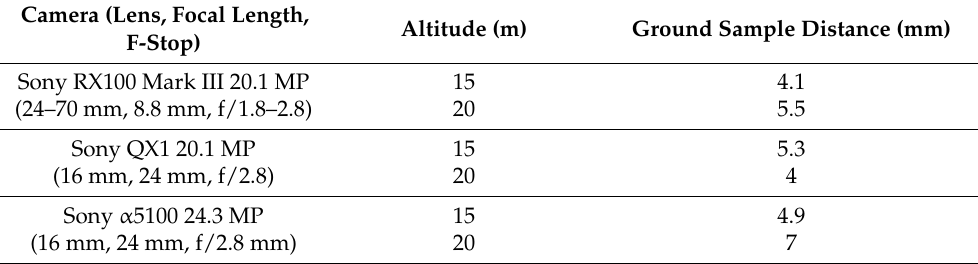
Table 2. Ground Sample Distance (GSD) of each camera/altitude combination used throughout the experiment. GSD is the distance between two consecutive pixel centers measured on the ground, it is a measure of camera spatial